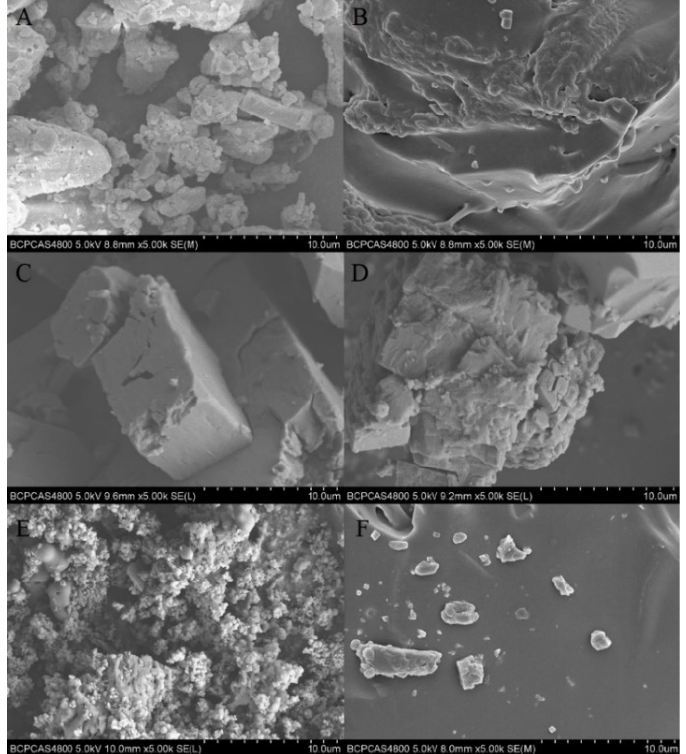
Figure 14. SEM photos of the additives and fracture morphology of PTPET composites: ( A , B ), PPSQ and PTPTE-PPSQ; ( C , D ) OPS and PTPET-OPS; ( E , F ) PhVPOSS and PTPET-PhVPOSS.